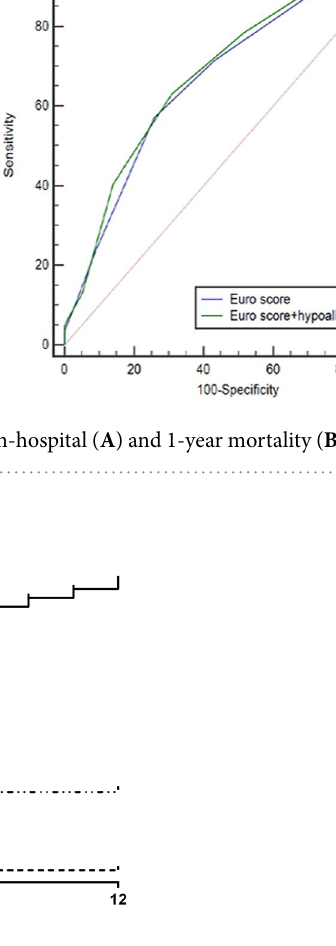
Figure 3. Cumulative rate of 1-year mortality after the operation, in patients with different risk